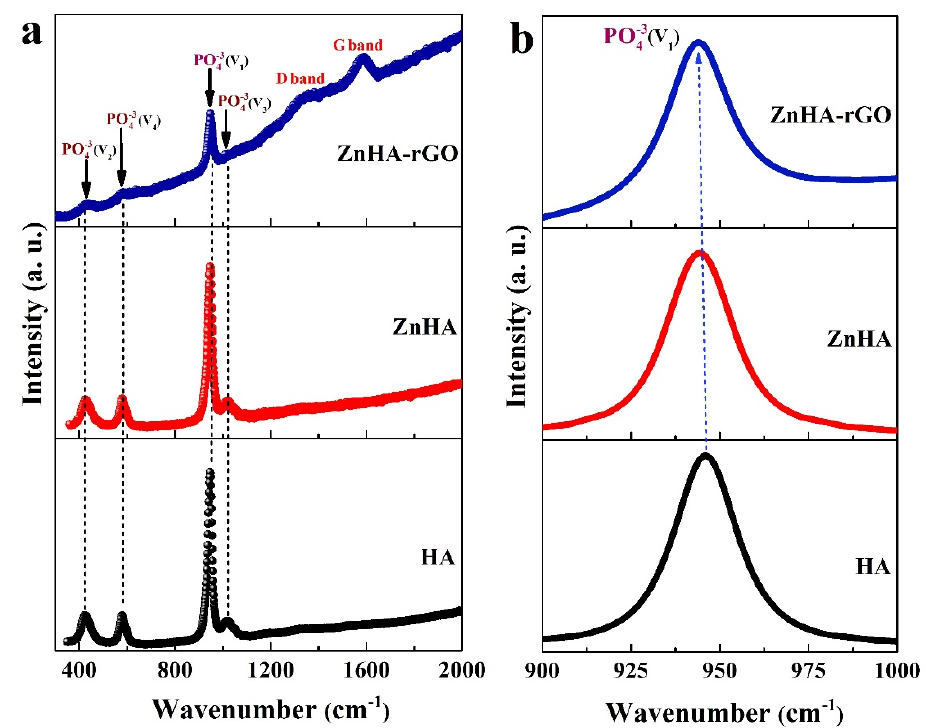
Figure 3. ( a ) Raman spectra of HA, ZnHA, and ZnHA-rGO nanoparticles, ( b ) Raman spectra in 900–1000 cm − 1 range. Raman spectra indicate that the rGO nanosheets wrap the surface of ZnHA nanoparticles. Zn doping in the HA structure and its compositing with rGO has made PO 43 − bands lower and broader.